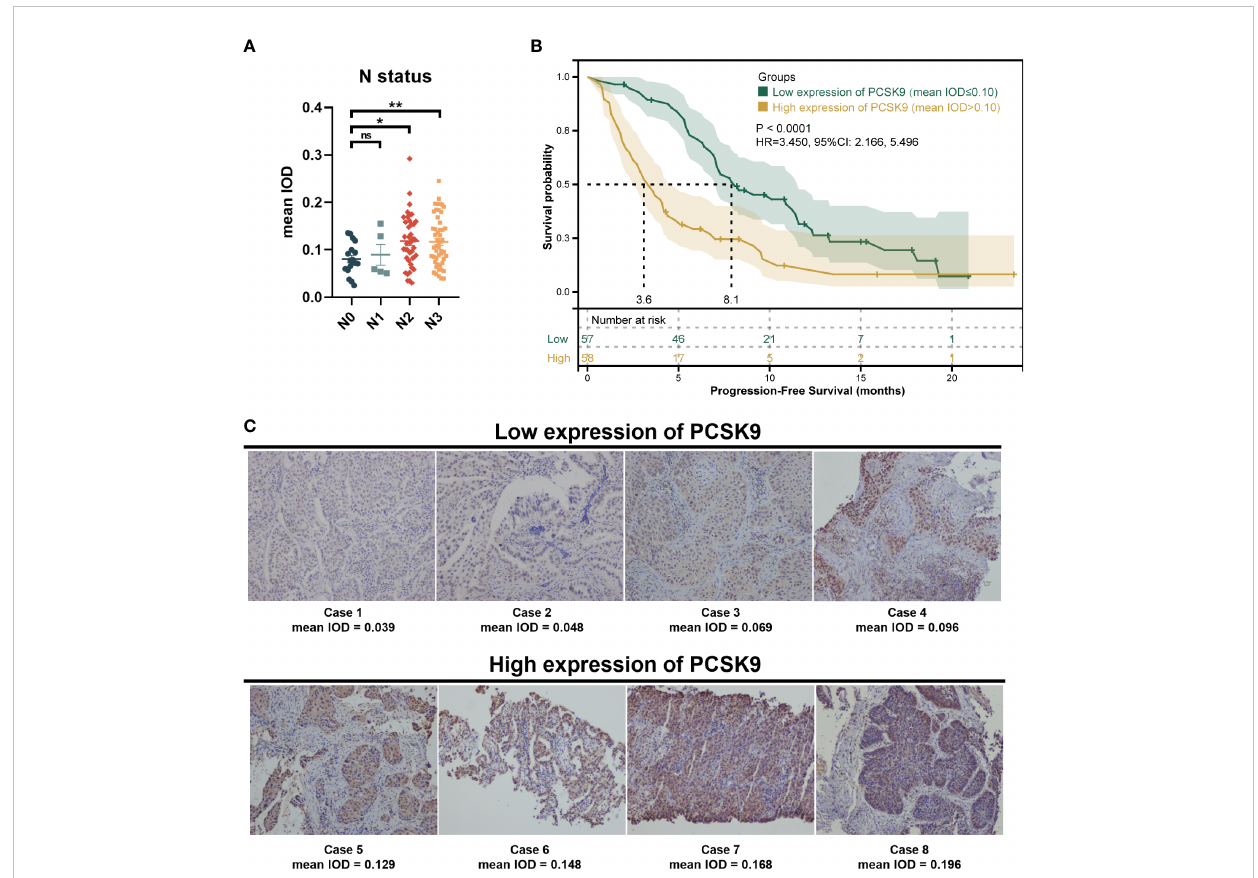
FIGURE 1 Immunohistochemistry of proprotein convertase subtilisin/kexin type 9 (PCSK9) in advanced non-small cell lung cancer (NSCLC) tissues. (A) PCSK9 expression in NSCLC tissues was associated with the N status of advanced NSCLC patients. (B) Kaplan – Meier estimate for PFS of the PCSK9 hi and PCSK9 lo groups by a proper cutoff of mean IOD of PCSK9 expression. The data cutoff was 30 April 2022. (C) Immunohistochemistry staining for PCSK9 of NSCLC tissues from advanced NSCLC patients before receiving anti-PD-1 immunotherapy. *ns, No signi fi cant difference, * P < 0.05, ** P < 0.01.